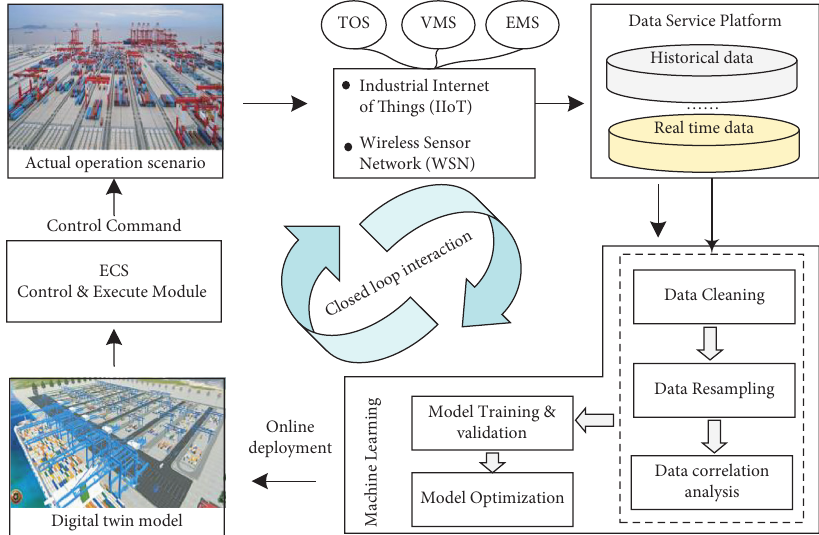
Figure 5: Machine learning-based DT